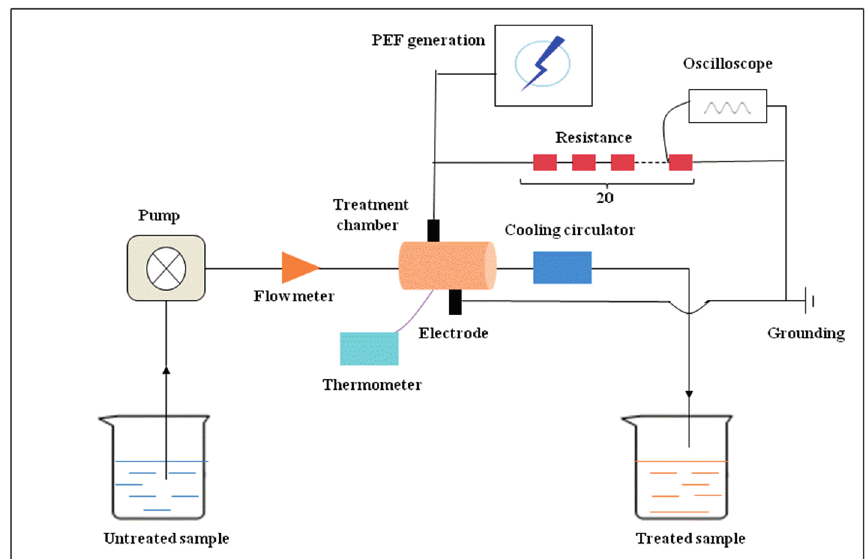
Figure 7. The scheme of the PEF treatment system used in the experiment. Table 2. The energy input ( Q , kJ/cm 3 ) of PEF in the different treatment condition. Electric Field Strength